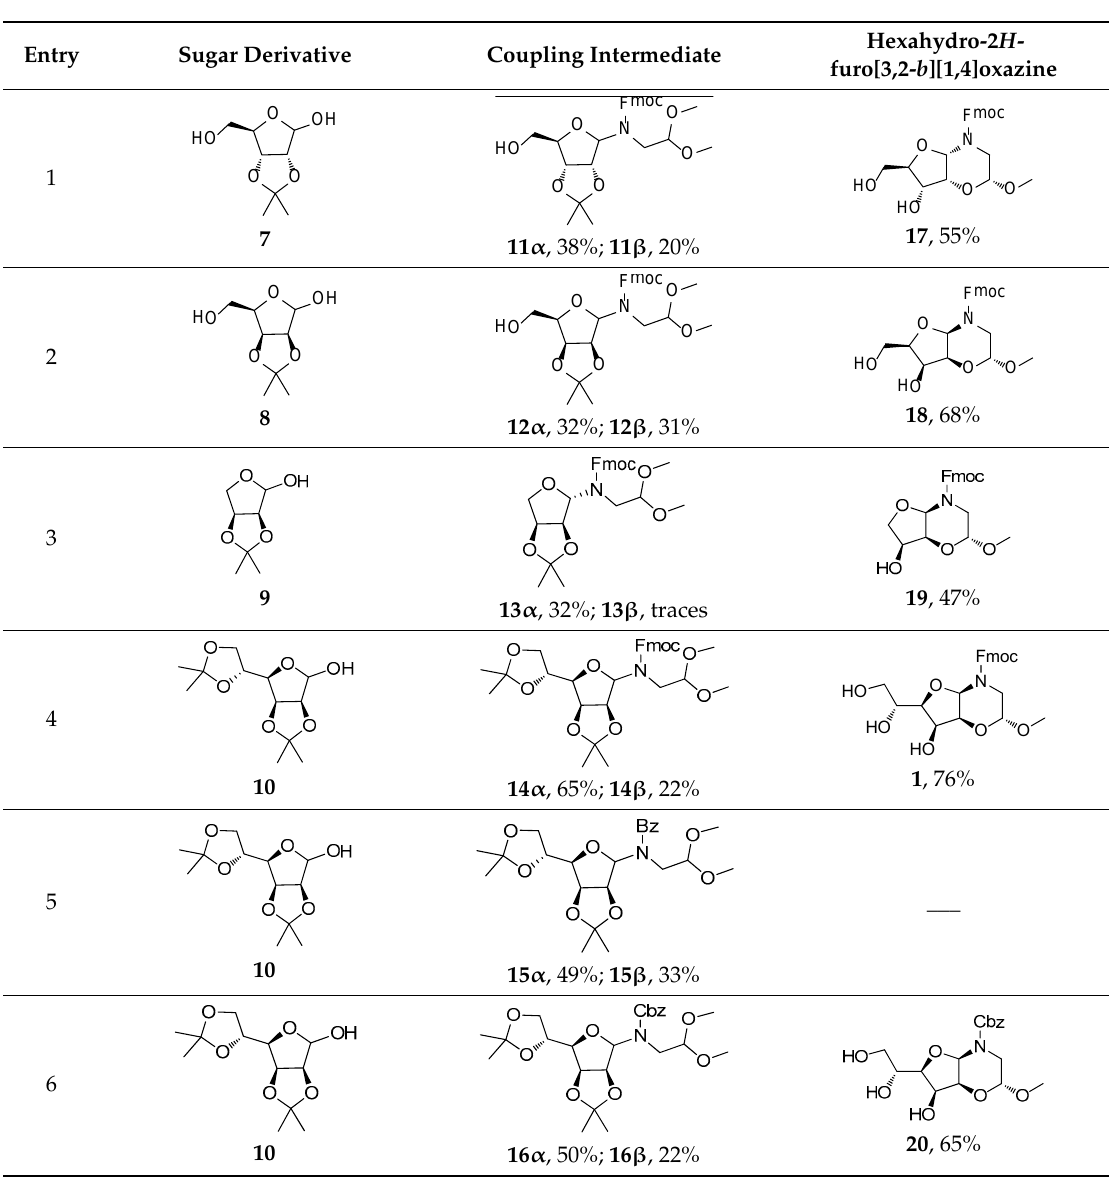
4 of 17 Figure 4. Control cells after 48 h ( left ), and cells after 48 h of incubation with compound 1 at 10 μM concentration ( right ). Figure 5. Left : Cell growth inhibition in MDA-MB-231 cells after 48 h of incubation with compound 1 at the reported concentration; Right : dose-response curve of log[ 1 ] vs. % cell growth normalized to control. Values indicate the mean of three independent experiments. Error bars show the corresponding standard deviation values. In order to study and improve the activity of this compound, a pool of hexahydro-2 H -furo[3,2- b ] [1,4]oxazine compounds with different polyhydroxylated chains, stereochemistry, and amine functionalities, were synthetized following the two-step process as reported in Scheme 1 and Table 1.